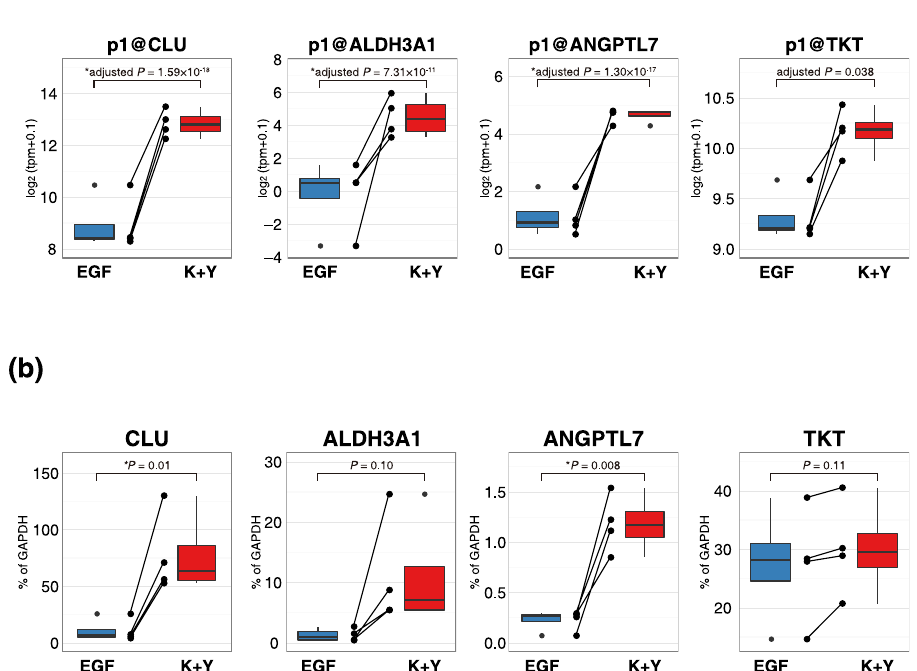
Figure 5. CEC-specific genes regulated by PAX6 are upregulated in K + Y-treated LECs. Expression levels of CEC-specific genes regulated by PAX6 quantified by (a) CAGE and (b) RT-PCR. Each dot represents the expression levels of distinct promoters or genes in each sample, and each line indicates binding to samples from the same donors. Asterisks represent statistical significance. K + Y: KGF and